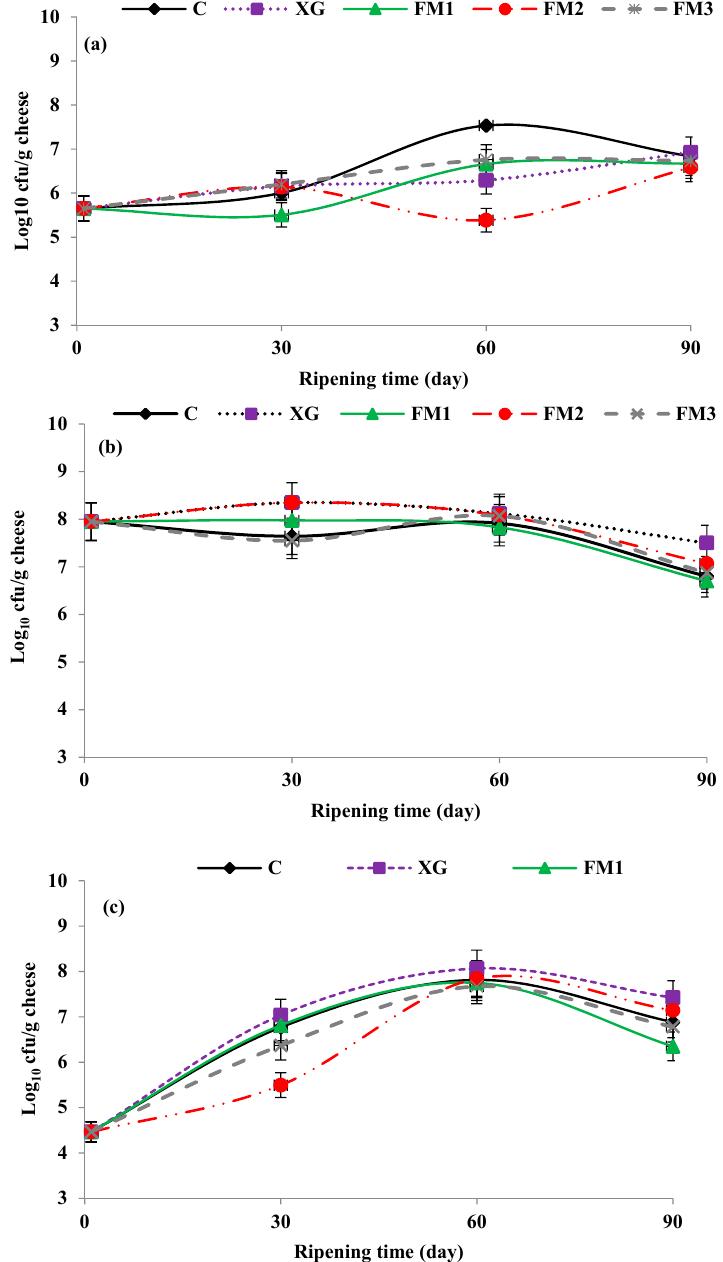
Figure 4. Variation in the counts of ( a ) NSLAB, non-starter lactic acid bacteria; ( b ) SB, starter bacteria; and ( c ) TMAB, total mesophilic aerobic bacteria in the coated Cheddar cheeses throughout 90 days of ripening. C, control, coated with polyvinyl acetate; XG, coated with 0.5% xanthan gum; FM1, FM2, and FM3 coated with 0.75%, 1%, and 1.25% flaxseed mucilage, respectively. Each dot represents the mean of the experimental data with an error bar of three replications.